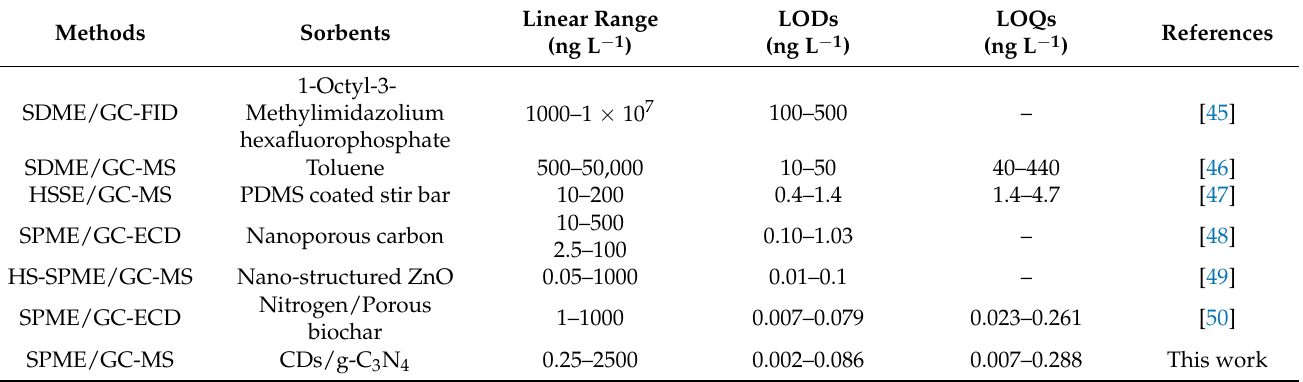
Table 2. Comparisons with other analytical methods for the determination of CBs in